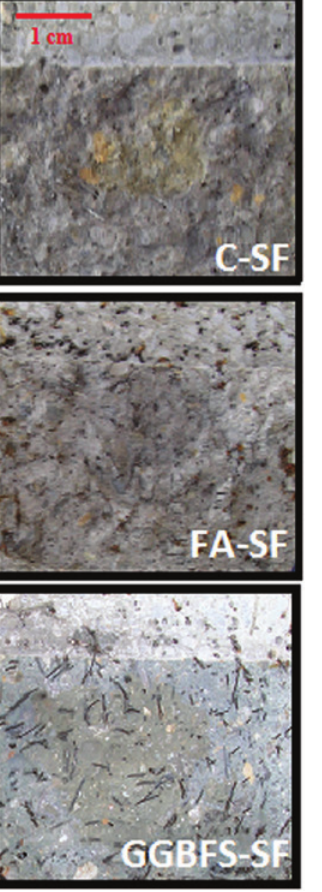
Figure 14 Cross-section (40 × 40 mm) of fibered SCRM series after F-T